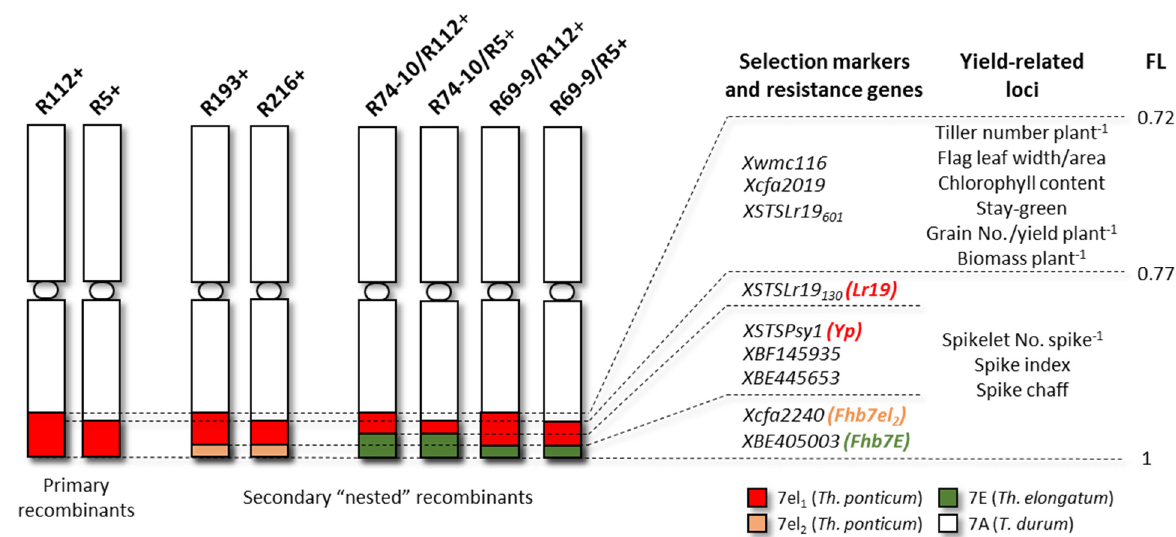
Figure 1. Cytogenetic maps of 7A chromosomes of recombinant lines and loci for yield-related traits, associated with Th. ponticum 7el 1 L segments of primary recombinants (adapted from [29,37]). Resistance genes are indicated in the colour of wild species of origin; FL, fractional arm length of the distance from centromere (0) to telomere (1). Table 1. Durum wheat- Thinopyrum spp. recombinants analysed in the present study (RF, rainfed; IRR, irrigated; sp, spaced plants; sr, spike-row).